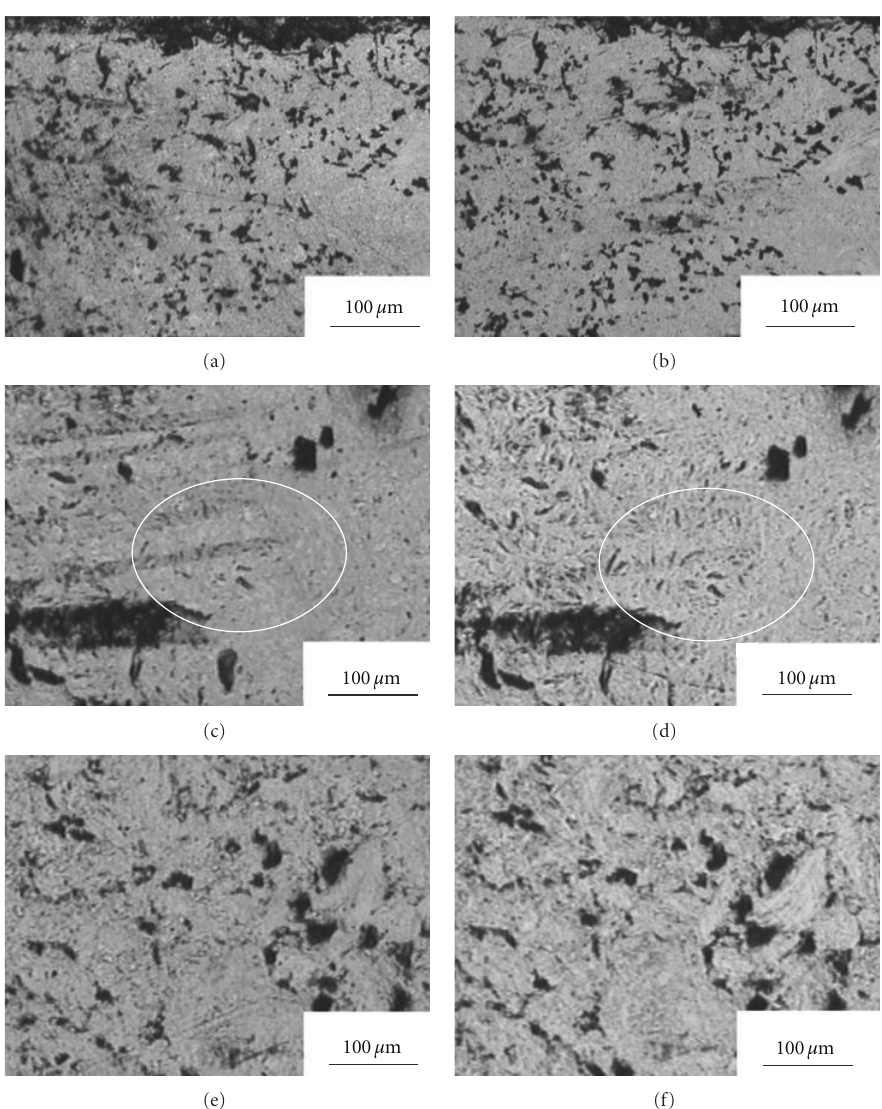
Figure 6: Graphite morphology before and after 20 keV He + irradiation with flux of 5 × 10 16 ions/cm 2 . (a) IG-11, (c) NBG18, and (e) HSM-SC before irradiation; (b) IG-11, (d) NBG18, and (f) HSM-SC after